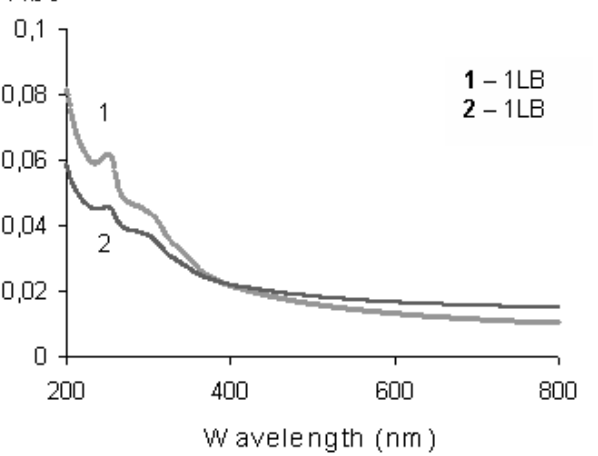
Figure 2. UV-Vis spectra of a one monolayer thick film of fluorene derivatives 1 and 2